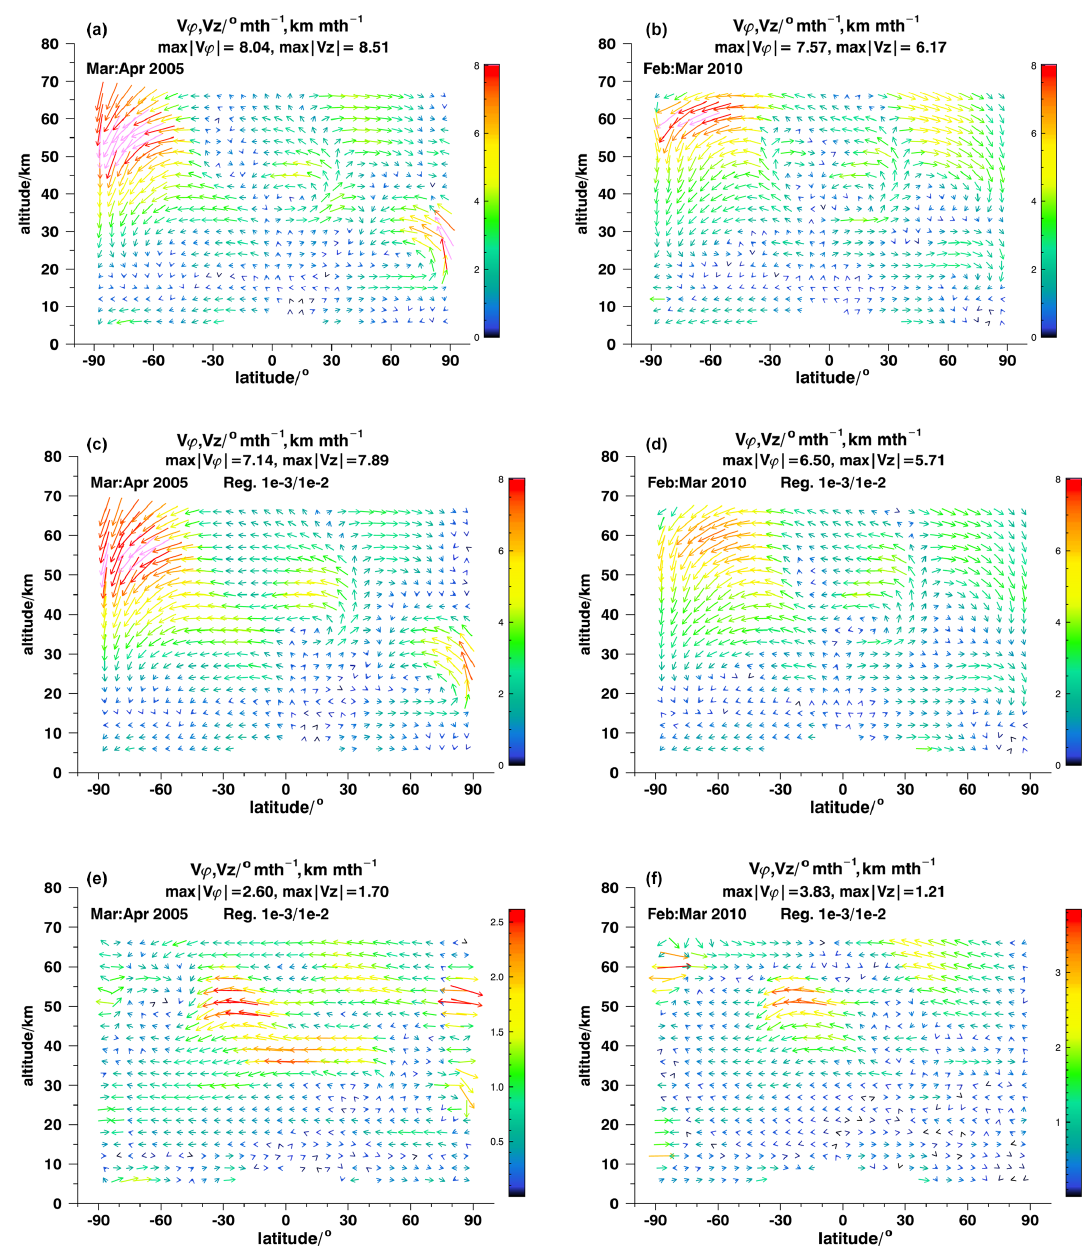
Figure 3. Model recovery tests for March–April, 2005 (a, c, e) and February March, 2010 (b, d, f) , reference fields (a, b) , results (c, d) , and differences (e, f) . Note the different color scales of the difference plots. For details, see Fig.